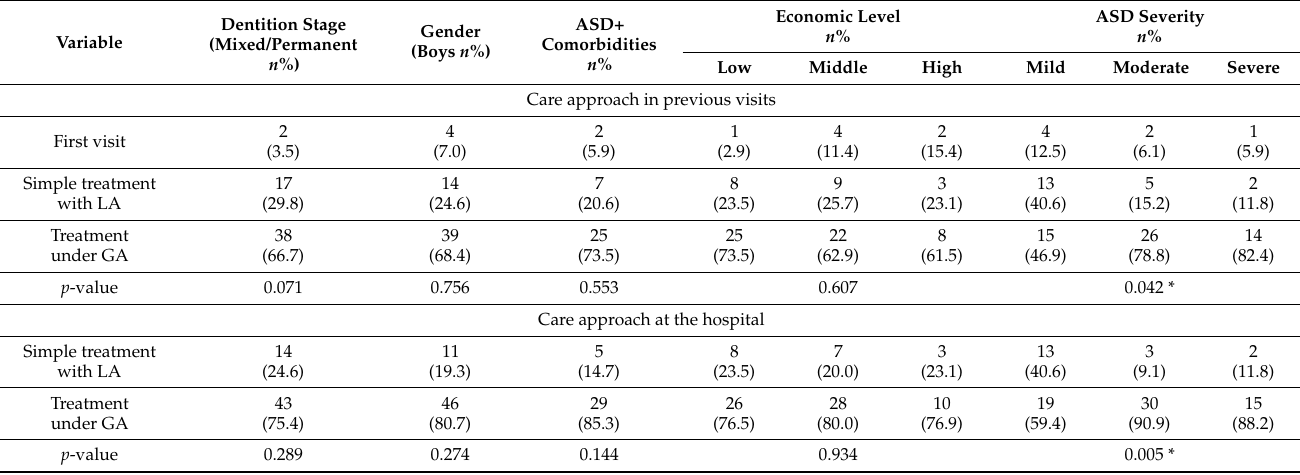
Table 3. Association of the demographic profile of ASD children ( n = 82) and their medical status with the care approach provided.